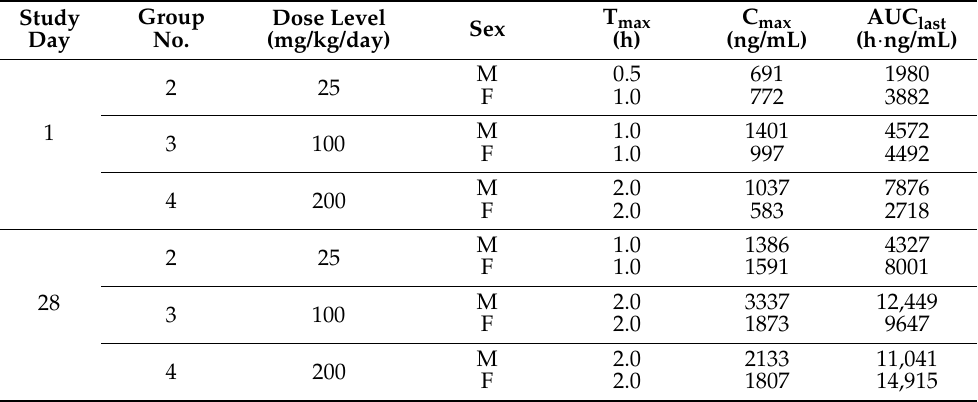
Table 6. ZB716 28-day repeated-dose TK parameters in beagle dogs.